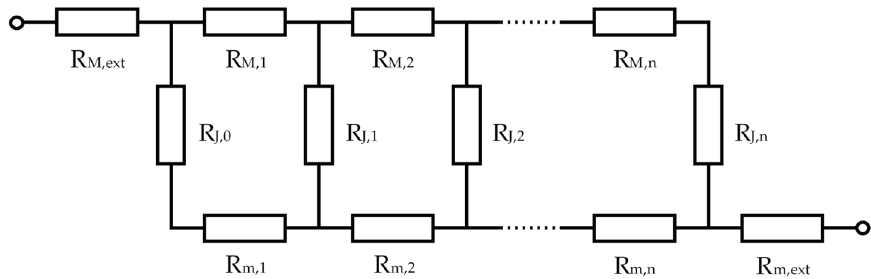
Figure 3. Model of the lap joint using an electrical equivalent circuit diagram.